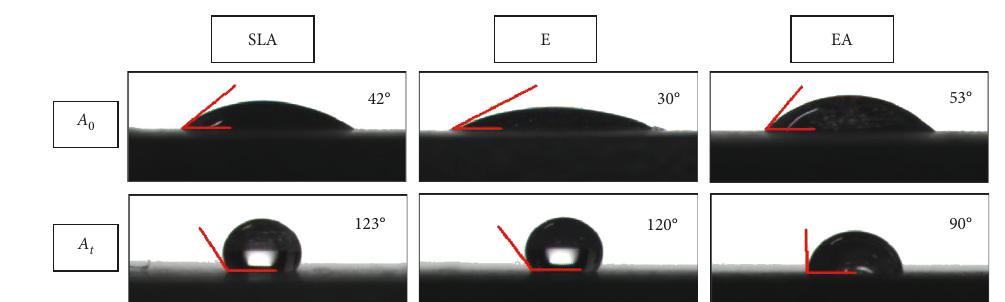
Figure 4: Water contact angles on SLA, E, and EA fresh surfaces ( A